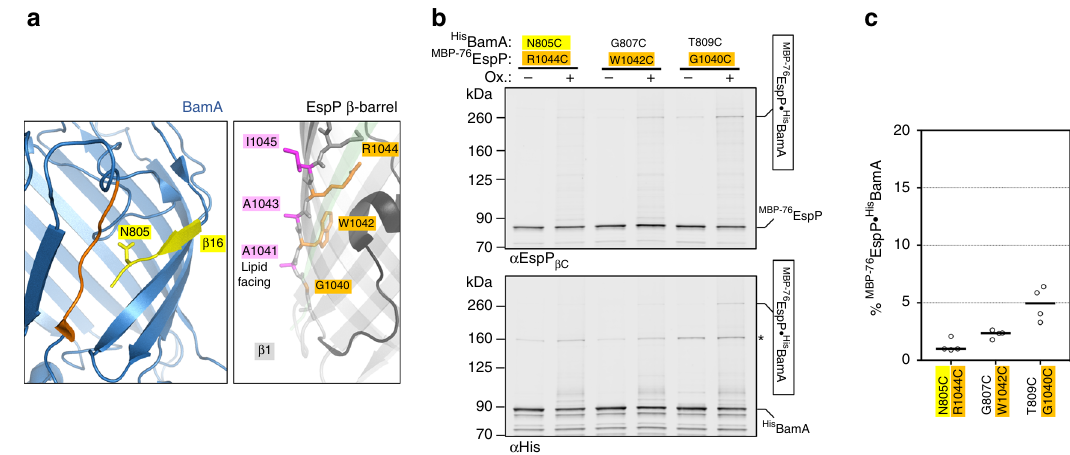
Fig. 3 MBP − 76 EspP( β 1) cysteines bond weakly with luminal-facing cysteines in BamA( β 16). a Left, view of BamA showing β -strand 16 (yellow) and lumen- facing residue N805. Note that the last several residues of BamA( β 16) are not resolved in available structures. Right, view of MBP − 76 EspP( β 1) showing lipid-facing (magenta) and lumen-facing (orange) residues. Foreground strands of the EspP β -barrel (including β 12, green) are transparent. b BL21(DE3) that expressed MBP − 76 EspP with a cysteine substitution at a luminal position in β 1 and His BamABCDE with a cysteine substitution at a luminal position in His BamA( β 16) were mock-treated ( − ) or treated with 4-DPS ( + ). Duplex-immunoblots were then conducted using antibodies/antisera against the C- terminus of MBP − 76 EspP ( α EspP β C ) and the N-terminus of His BamA ( α His) to monitor disul fi de-bond formation between cysteine pairs in vivo. Non-speci fi c bands are denoted (*). Data are representative of at least two independent experiments. c Quantitation of disul fi de-bond formation between MBP − 76 EspP ( β 1)- His BamA( β 16) cysteine-pairs in cells that were 4-DPS-treated. Experiments were performed as in b except that only α StrepII was used for probing immunoblots. Bars = median, N = 4. ANOVA and multiple comparison tests are shown in Supplementary Table 2. Source data are provided as a Source Data fi